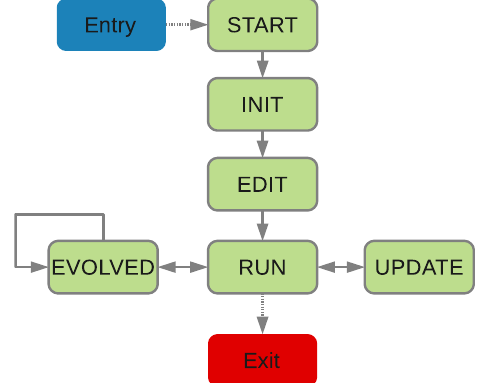
Figure 7. Example of a state model in OMUSE. The diagram gives the states that a simulation code can be in. Transitions between these can be triggered by explicit calls to the corresponding func- tion (e.g., initialize_code from START to INIT) or implic- itly (e.g., querying the grid state of a code may only be possible in the RUN state, and in this case the framework will call the necessary functions in order to get to the RUN state, guaranteeing a consistent state of the simulation code in the process). Adapted from Pelupessy et al.